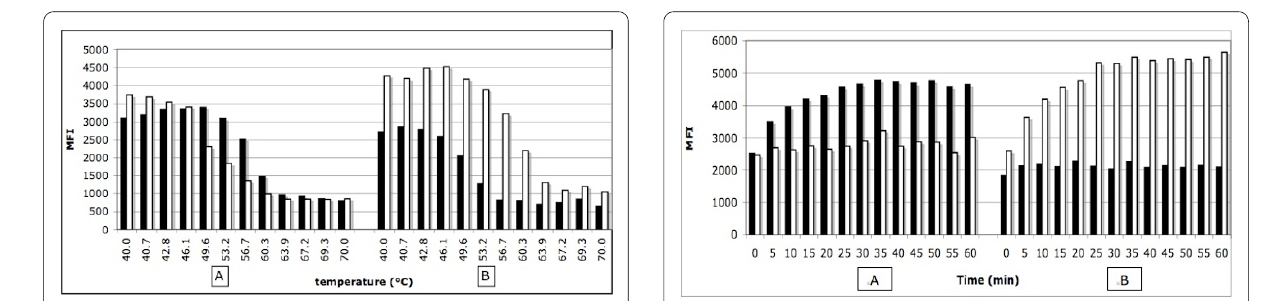
Figure 3 Effect of time on the kinetic of hybridization . Panel A; ho- mozygous wild type DNA, panel B: homozygous mutated DNA. Black bars correspond to the wild type probe (V617Fwt) and white bars cor- respond to mutated probe (V617Fmut). MFI: median fluorescent inten- sity.